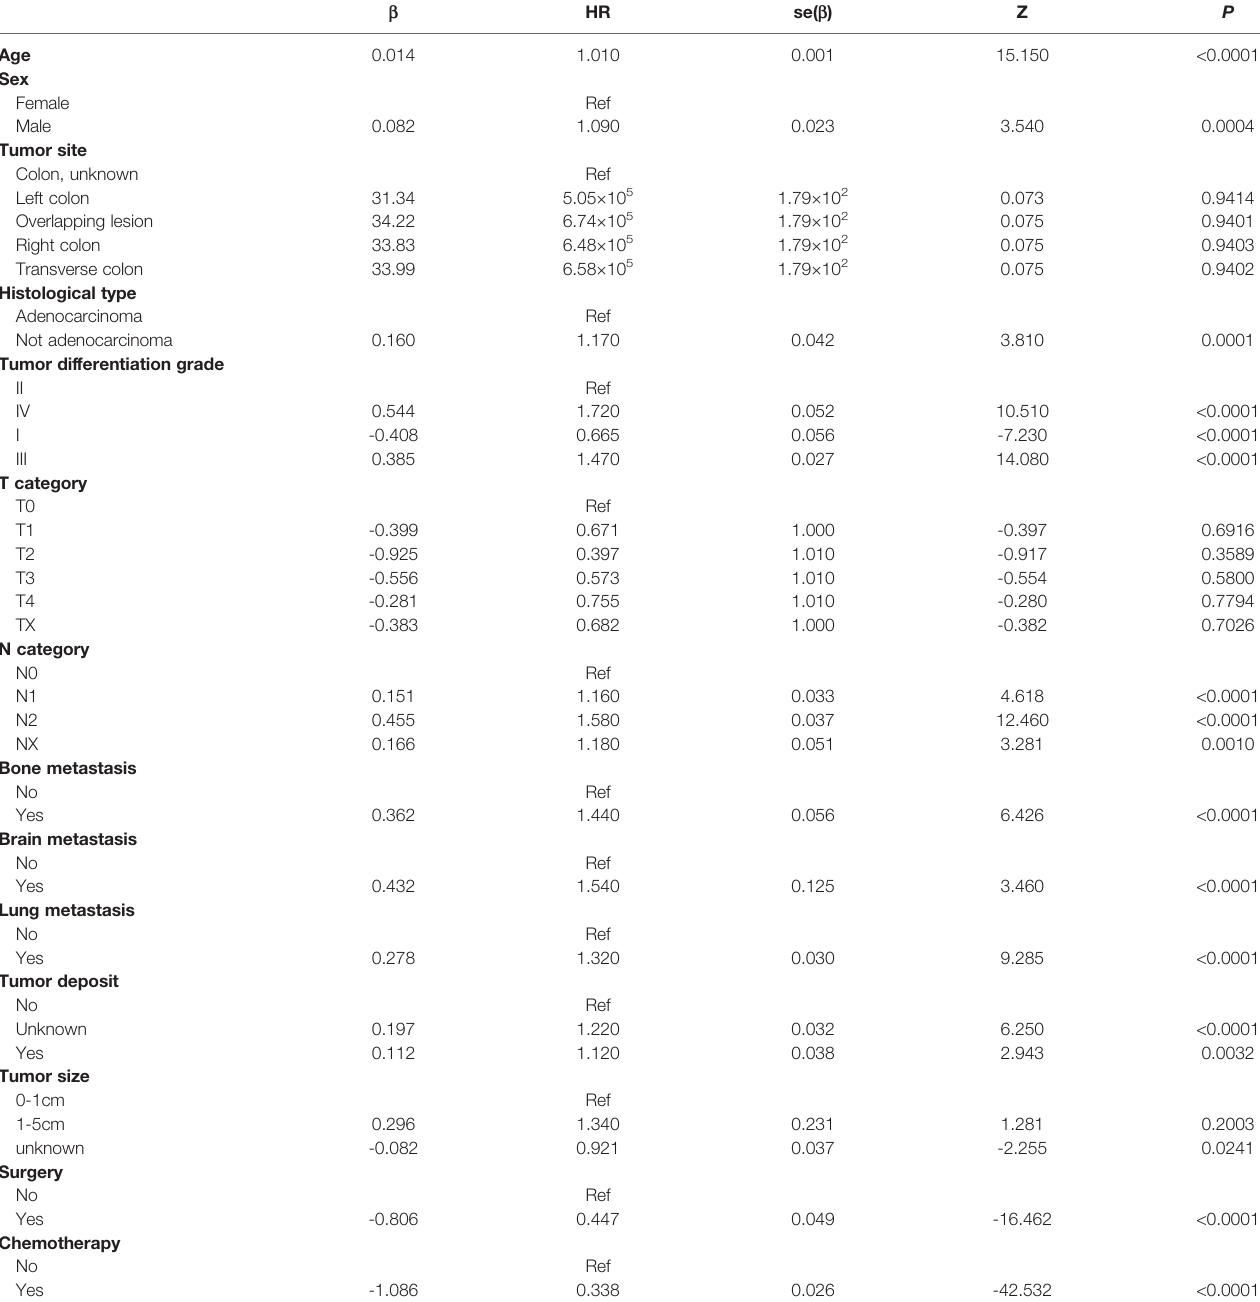
TABLE 3 | Multivariable regression for